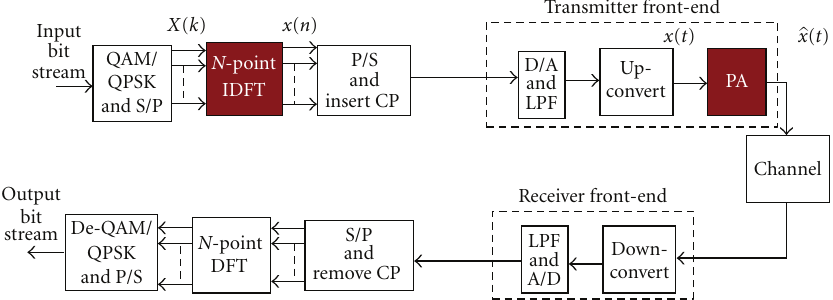
Figure 1: Block diagram of an OFDM transceiver with the power amplifier (PA).